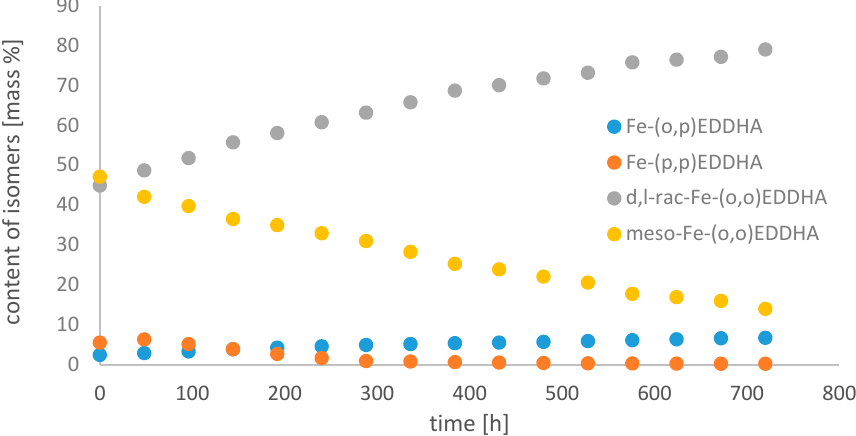
Figure 9. Change in the content of iron(III) ethylenediamine- N,N ′ -bis(hydroxyphenylacetic) acid isomers with time in an aqueous solution at pH 5.